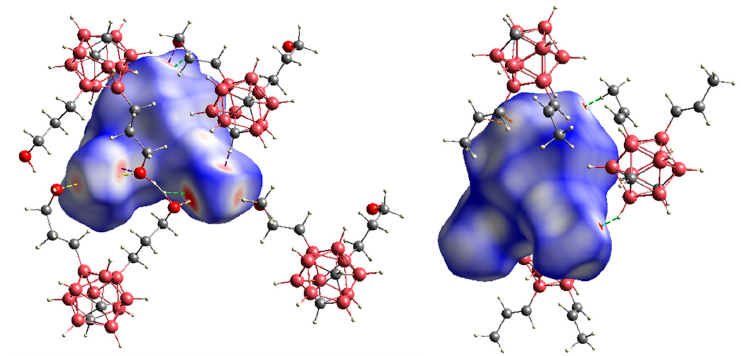
Figure 8. Presentation of close contacts for 4 (on left) and 12 (on right) through the d norm.